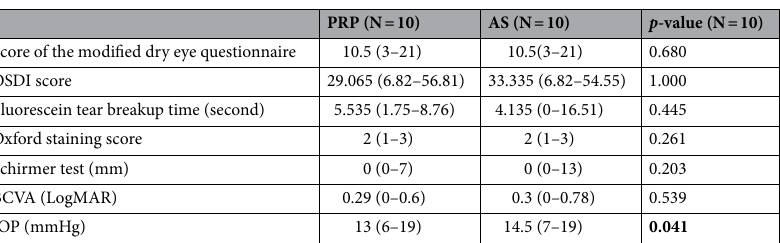
Table 1. Characteristics of the patients at baseline. All data presented as median (range) and analyzed by Wilcoxon signed rank test. p- values in bold are statistically significant.